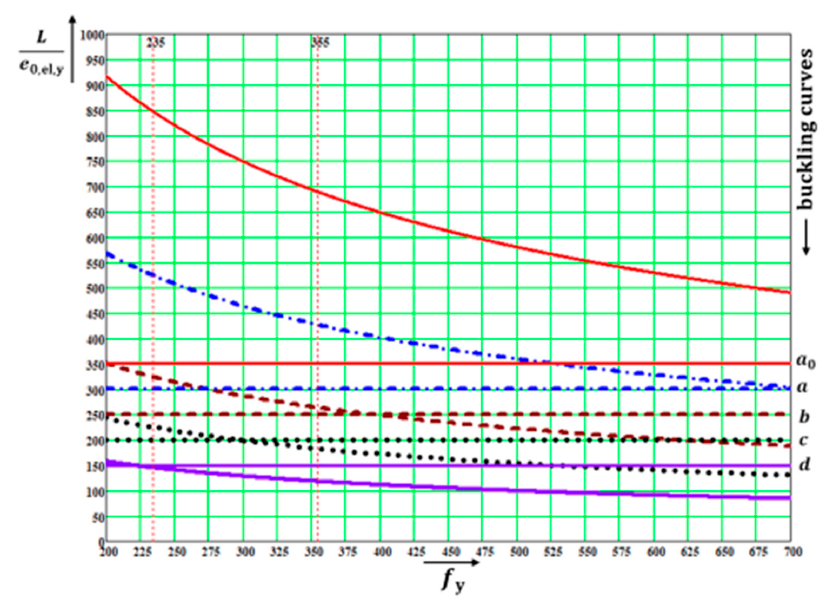
Figure 19. Comparison of horizontal lines [7] to the curves [17] defining bow imperfection e 0,el,y .